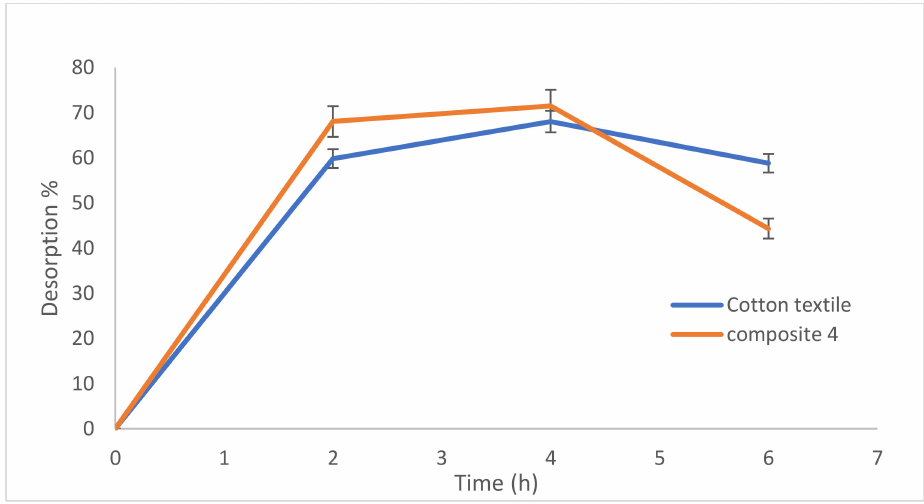
Figure 7. Desorption % of lead ions with composite 4 and cotton textile in nitric acid